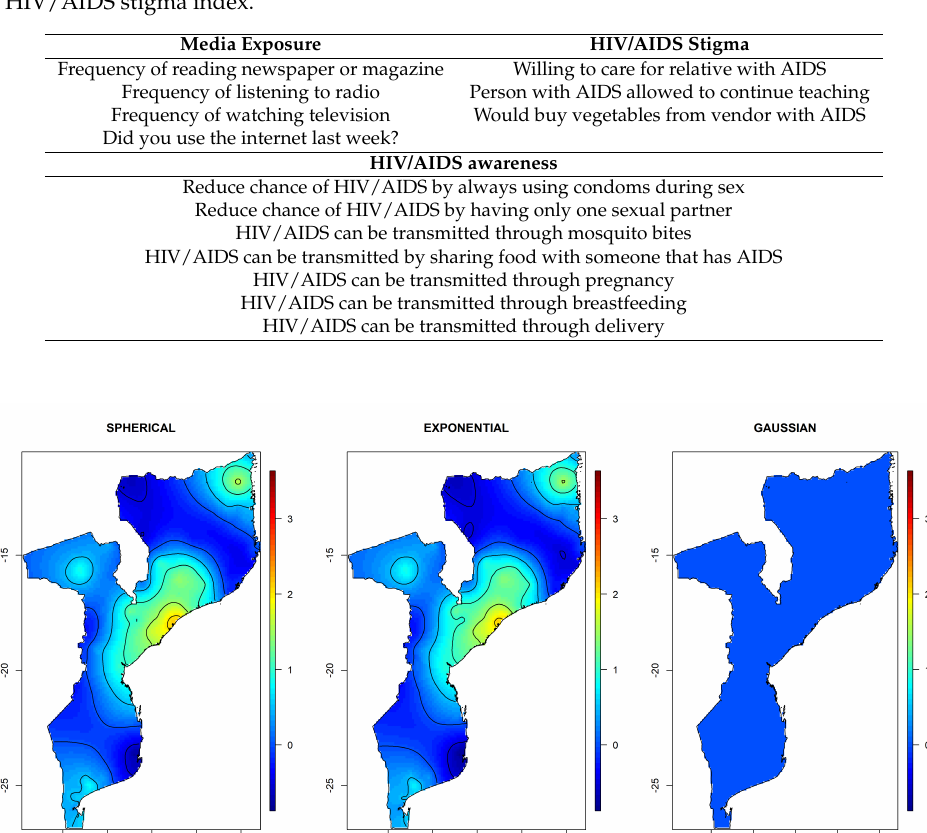
Figure A2. Image plots of the radial spline basis with ˆ τ = max functions. The radial spline basis is plotted on natural log-odds scale. This illustrates the spatial variation of HIV risk in